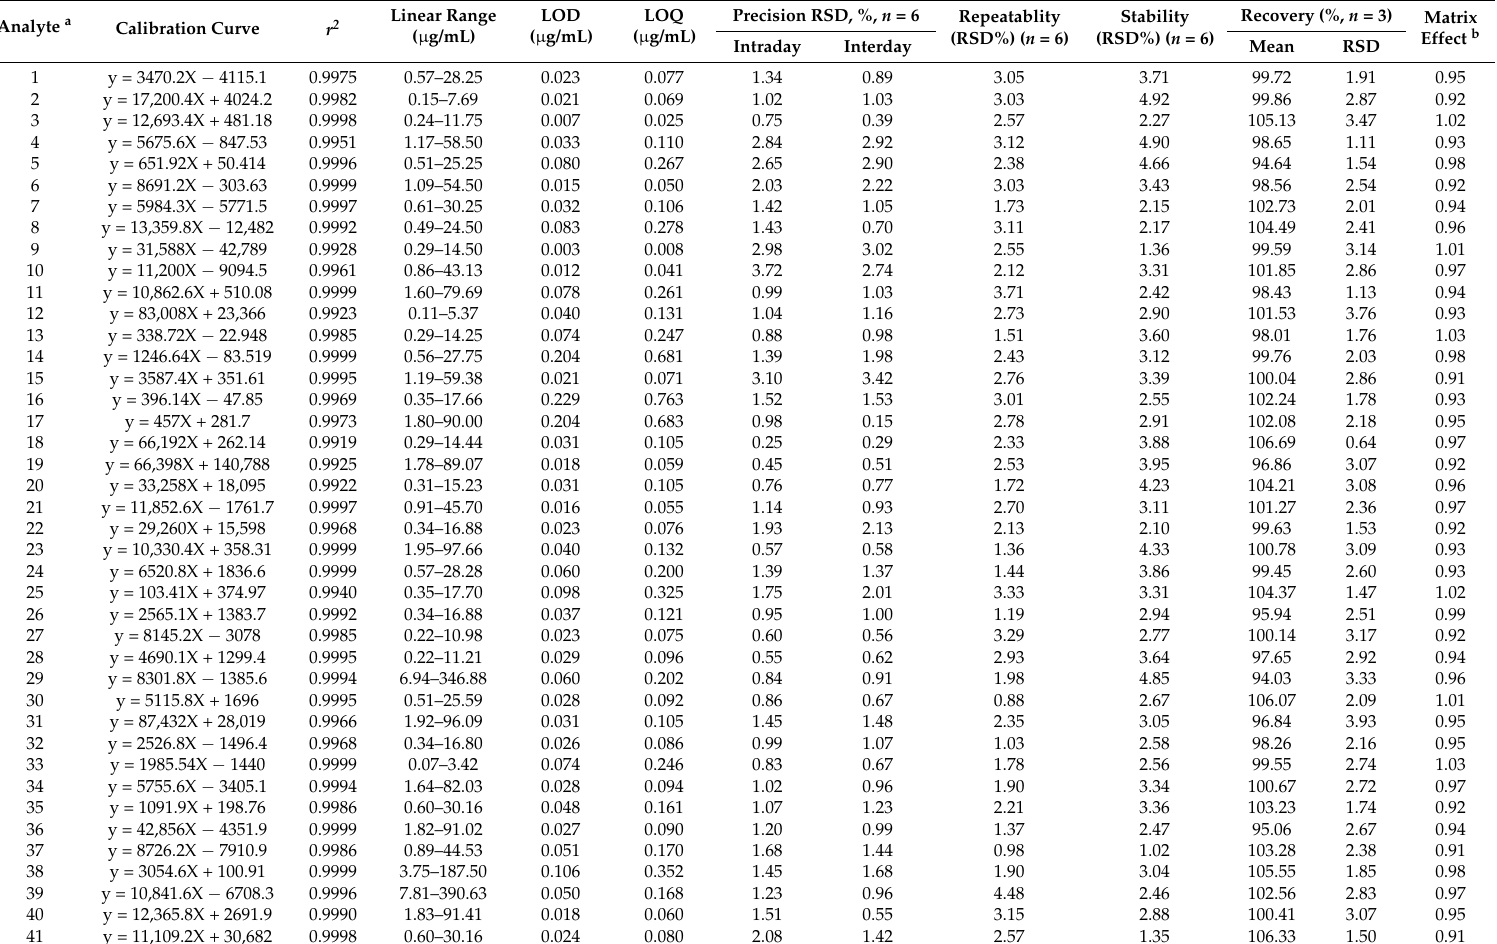
Table 2. Calibration curves, LOD, LOQ, precision, repeatability, stability and recovery of the 41